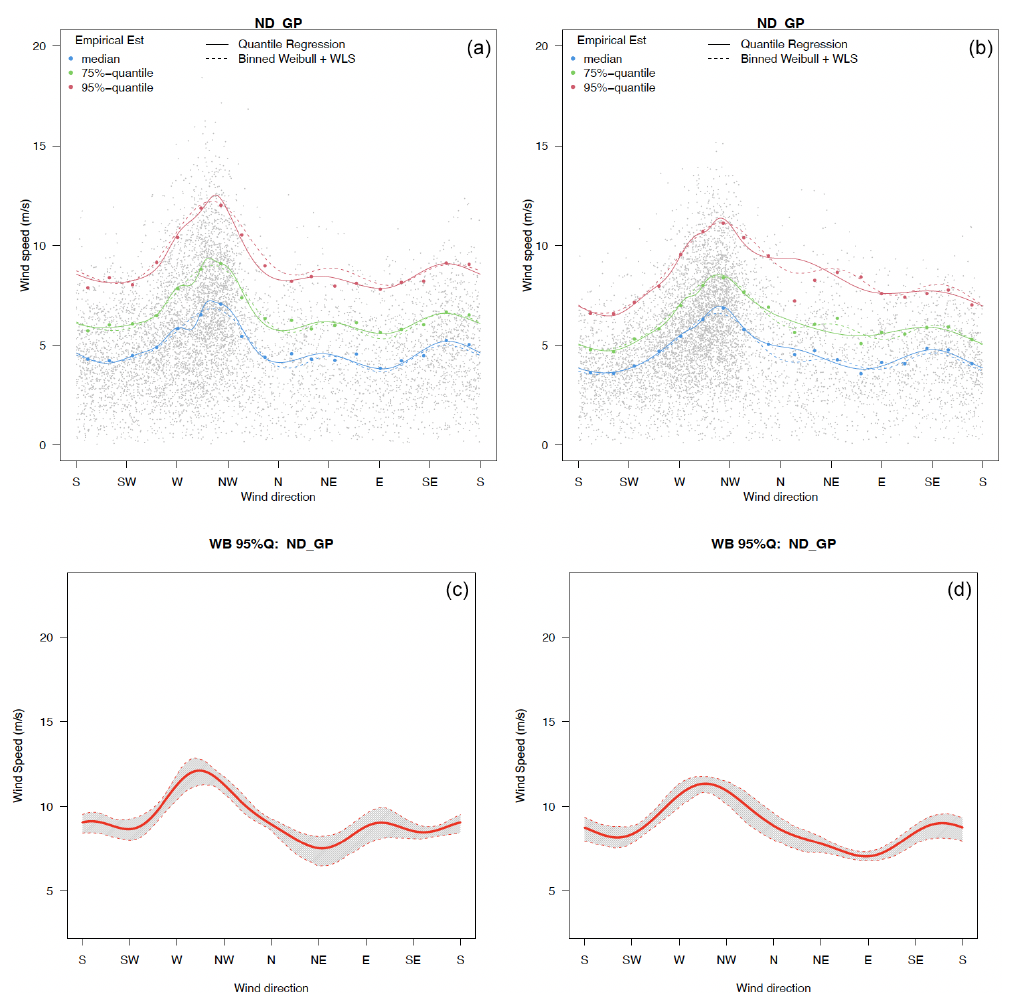
Figure 9. Estimated wind speed quantiles ( a, b ; blue for the 50th, green for the 75th, and red for the 95th quantile) conditioned on wind direction and their bootstrapping estimation uncertainties ( c, d ; only results for the 95th quantile are shown) at the northern Great Plains (NGP) grid cell for winter season under the historical (a, c) and late century periods (b, d) . Table 1. The 10-year-based IV and PCCs from WRF-CCSM. The asterisk indicates 2 > PCC Note: NC is North